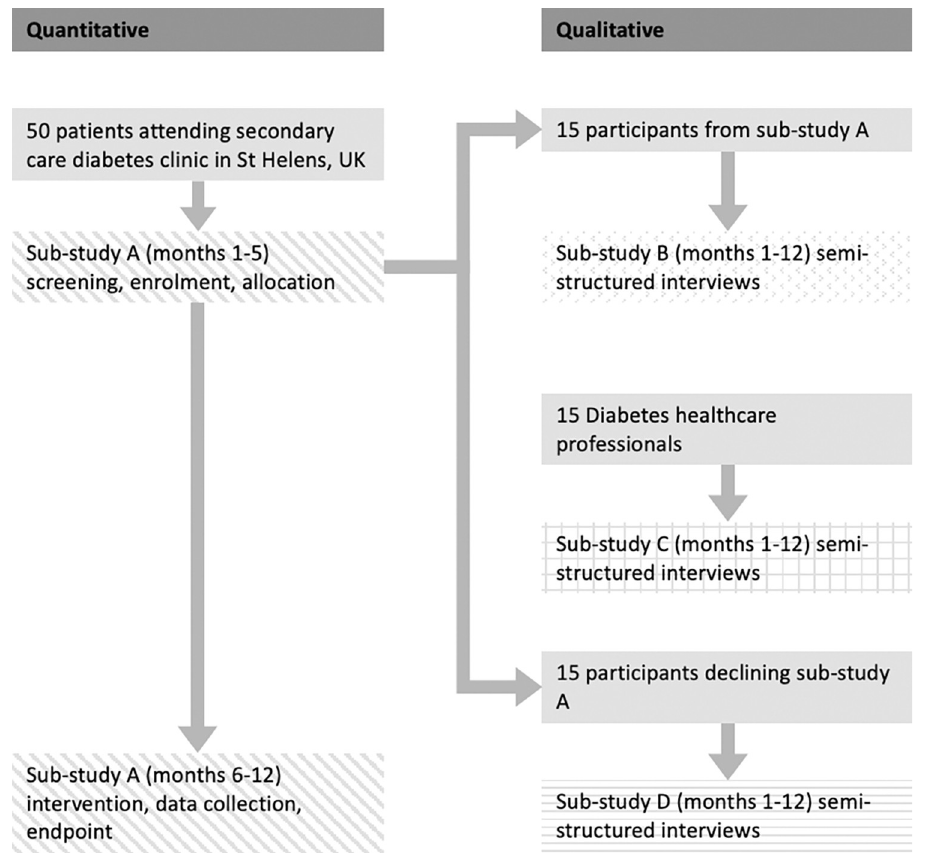
Fig 2. Flowchart demonstrating the study process and